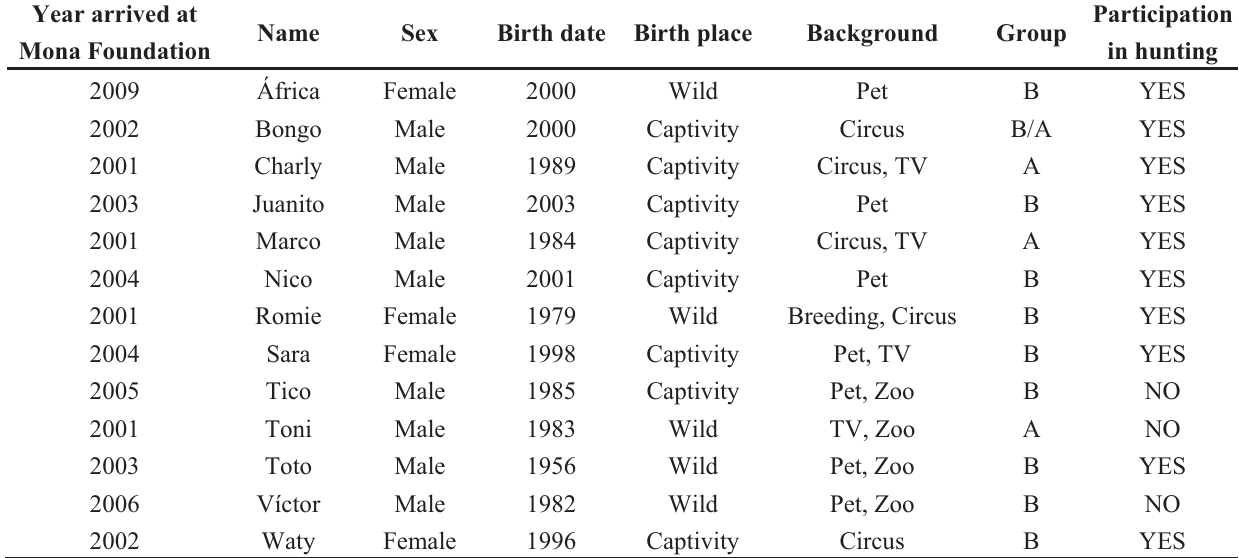
Table 1. Additional traits of the Fundació Mona (FM) chimpanzees: sex, age, place of birth and origin. Year arrived